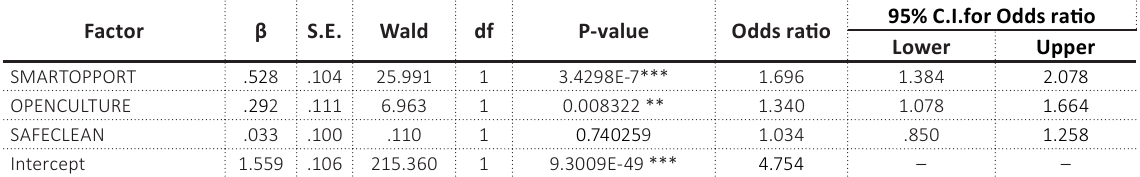
Table 4. Coefficients of the regional perception indicators components